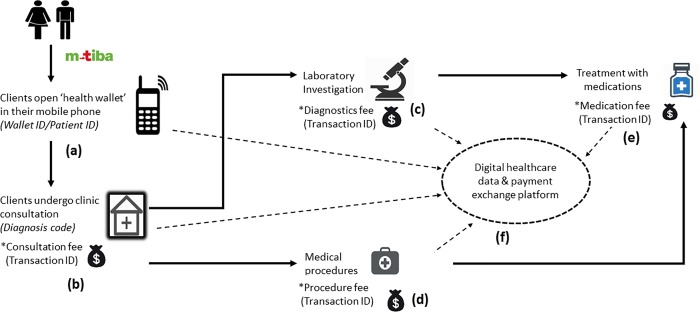
Diagram showing the digital healthcare exchange platform used to record patient information and to channel healthcare payments.